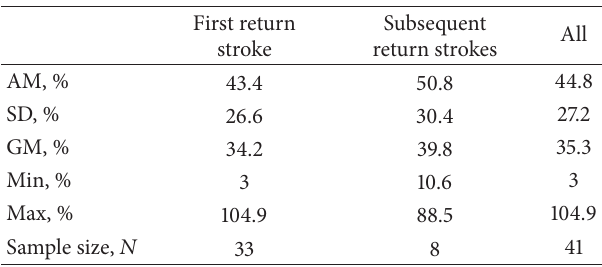
Table 6: Statistical summary of opposite polarity overshoot relative to peak.